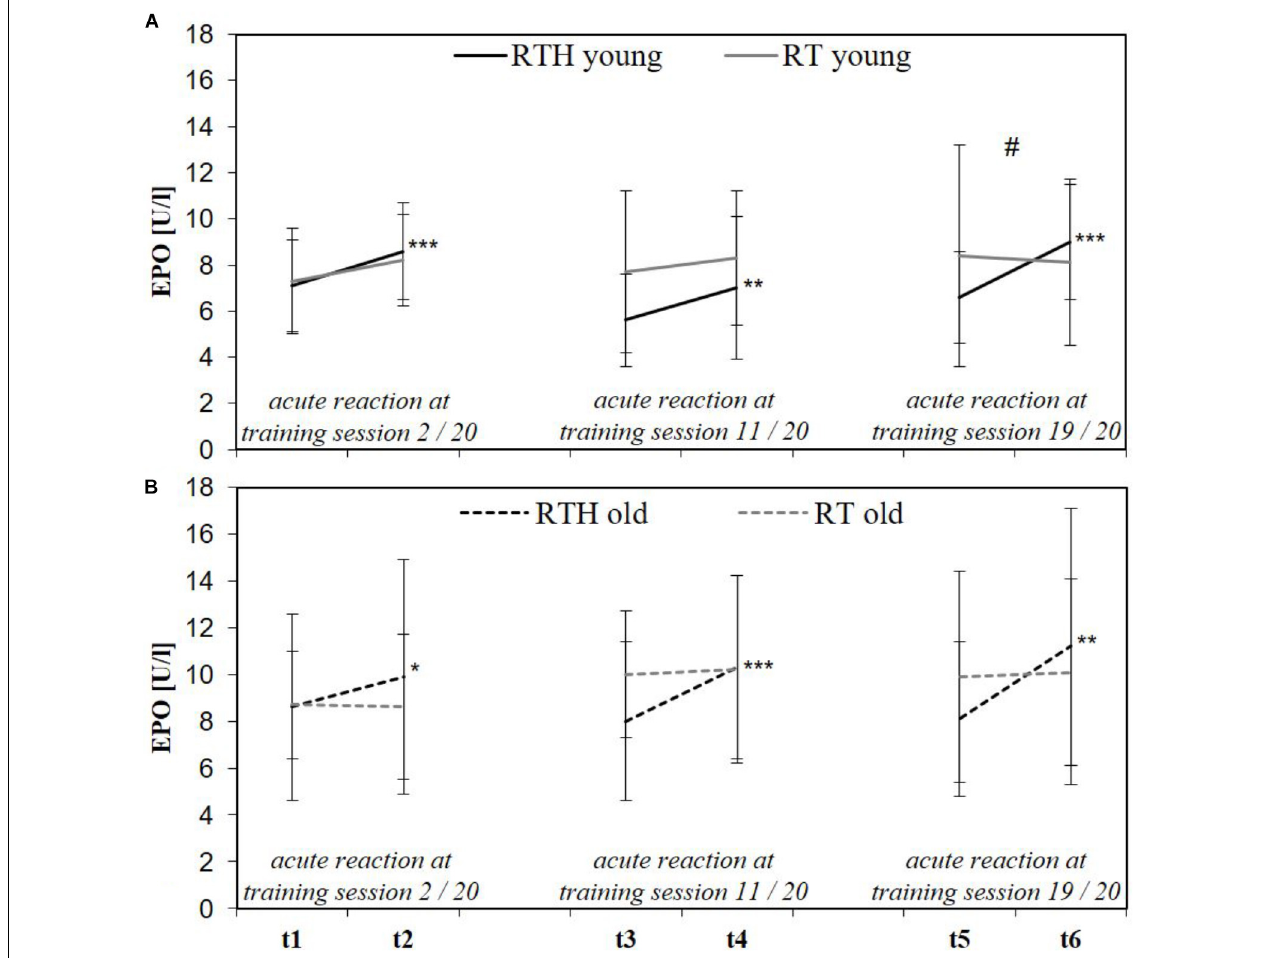
FIGURE 6 | Acute reaction of the erythropoietin (EPO) immediately before and after the 2nd (t1, t2), 11th (t3, t4), and 19th (t5, t6) of 20 training sessions in the young (A) and older (B) age cohort of the group RTH and RT [resistance training under normobaric hypoxia (RTH), resistance training under normoxia (RT); time ×